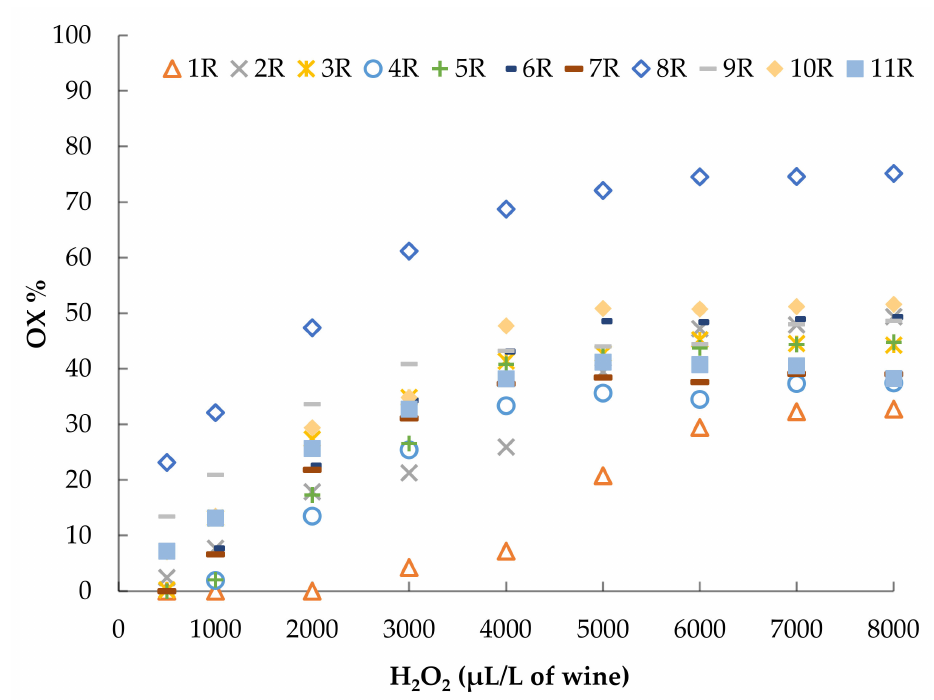
Figure 5. Results of the AOI test performed with increasing doses of 3% H 2 O 2 , from 500 to 8000 µ L/L of red